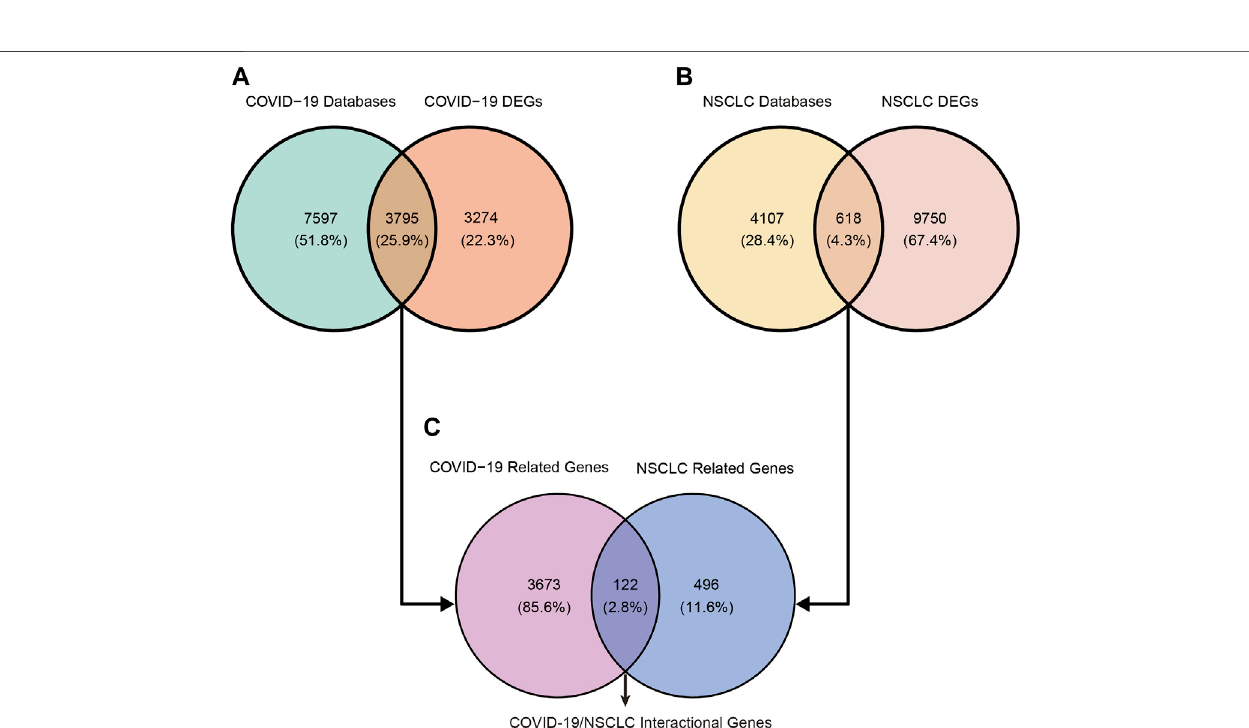
FIGURE2| Identi fi cationofCOVID-19/NSCLC interactionalgenesbyintersectingCOVID-19 – related genesandNSCLC-relatedgenesfrompublicdatabasesand DEGs from RNA-seq datasets. (A) Identi fi cation of COVID-19-related genes. (B) Identi fi cation of NSCLC-related genes. (C) Identi fi cation of COVID-19/NSCLC interactional